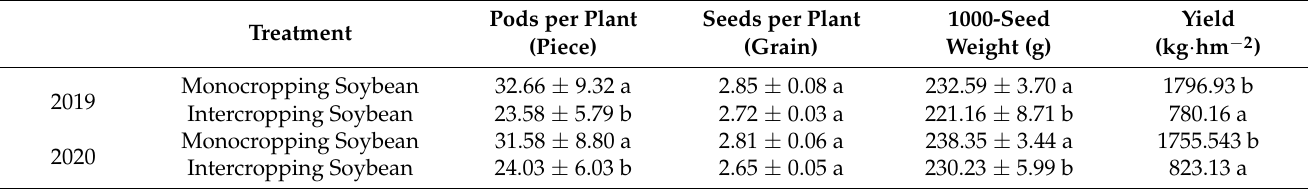
Table 4. Monocropping and intercropping soybean yield and yield components in 2019 and 2020. Treatment